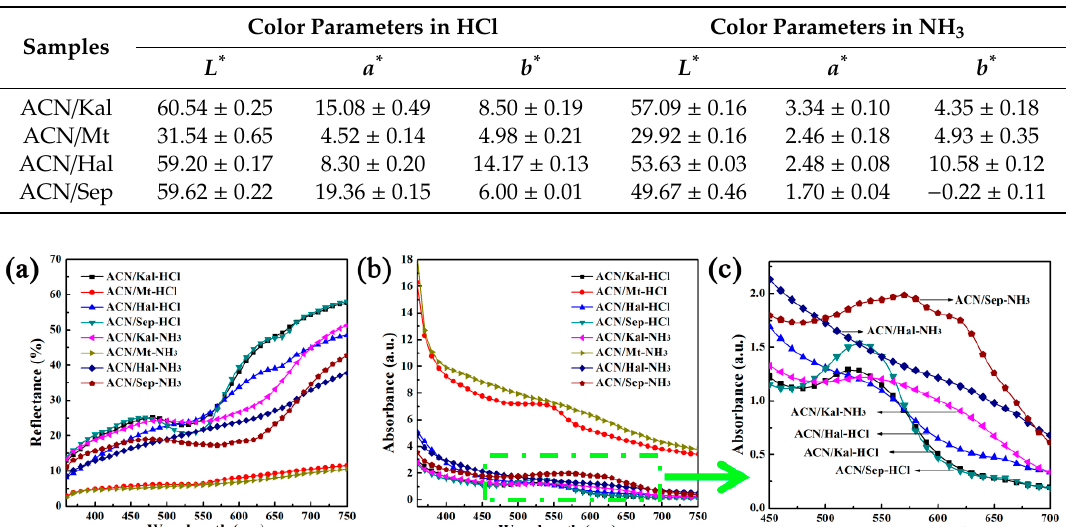
Table 4. Color parameters of the ACN / clay minerals before and after being exposed to HCl and NH 3 atmospheres for five cycles.